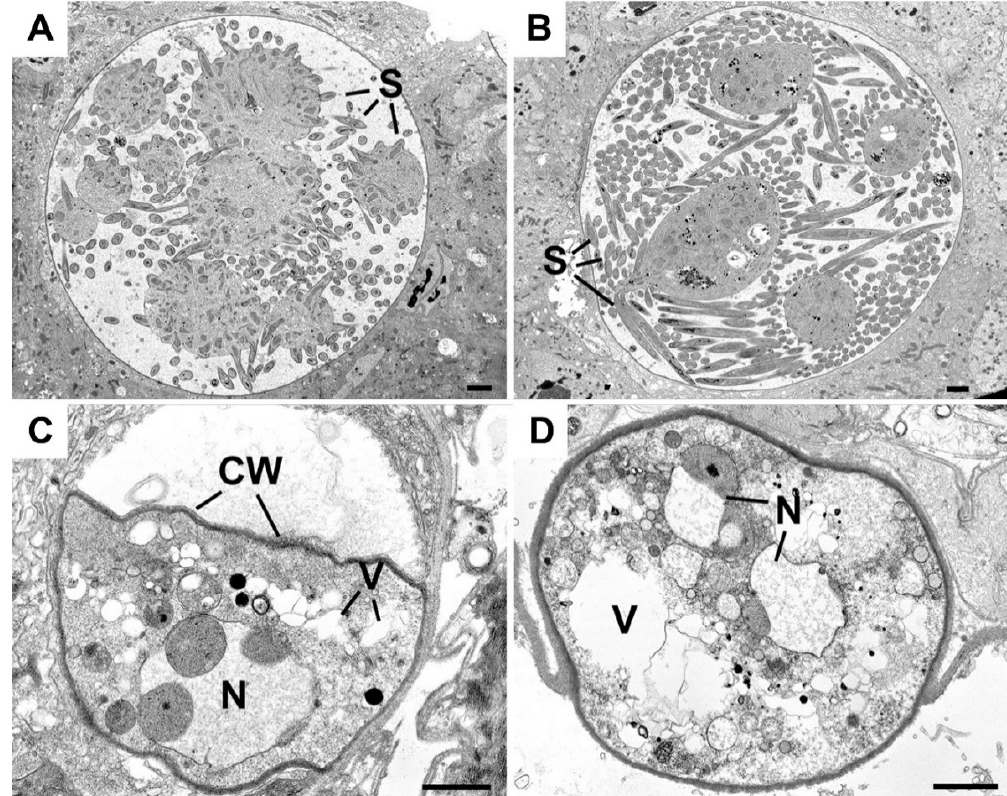
Figure 3. Ultrastructure images of the oocysts of WT and ∆ mre11 parasites at 14 days post-infection. ( A ) Mid-stage WT oocyst showing early stages of sporozoite formation (S) around the cytoplasmic mass. ( B ) Late-stage WT oocyst showing the large numbers of fully developed sporozoites (S). ( C , D ) Low power view through the ∆ mre11 oocyst showing the oocyst wall (CW) enclosing the degenerate contents with vacuolated cytoplasm (V) and swollen nucleus (N). Bars represent 10 µ m.